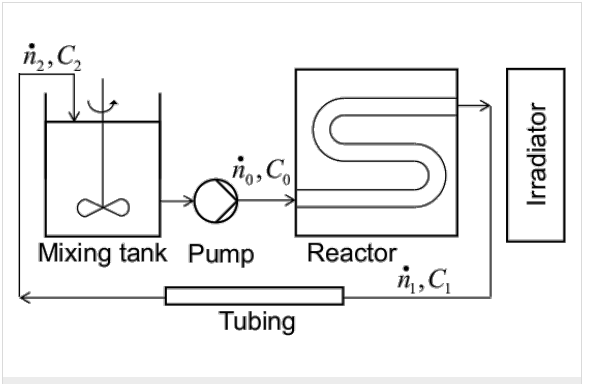
Figure 1: Schematic of the experimental setup consisting of a reser- voir, pump, photoreactor and